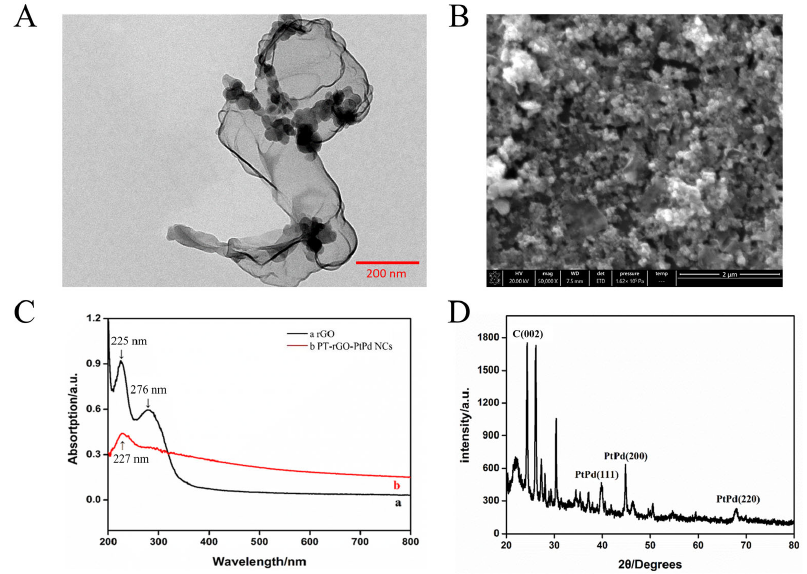
Figure 1. ( A ) The TEM image of PT-rGO-PtPd NCs. ( B ) The SEM image of PT-rGO-PtPd NCs. ( C ) The UV-visible spectrum of the rGO (a) and PT-rGO-PtPd NCs (b). ( D ) The XRD spectra of PT-rGO-PtPd NCs.